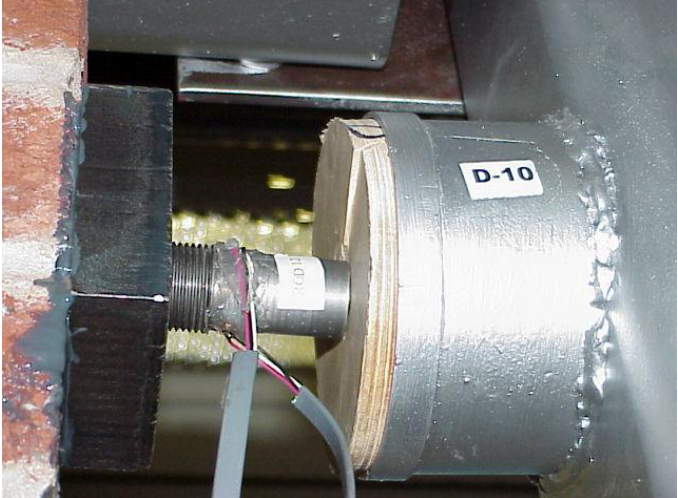
Figure 20. Cracking of 0.5 in. disk at fuse location 10 during test